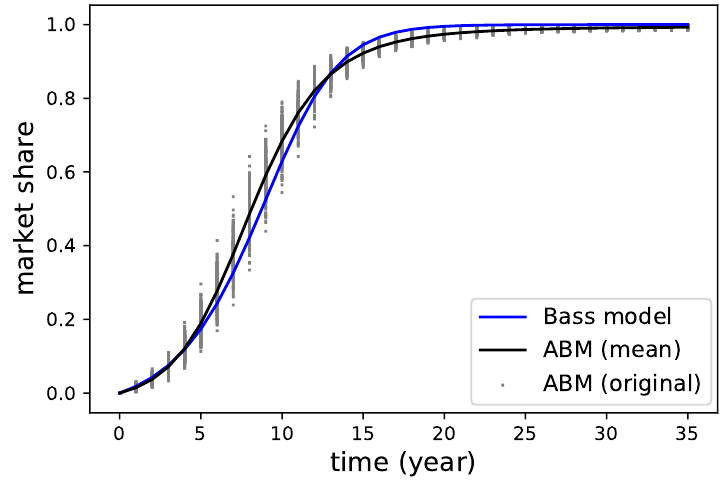
Figure 6. Model calibration ( R 2 =